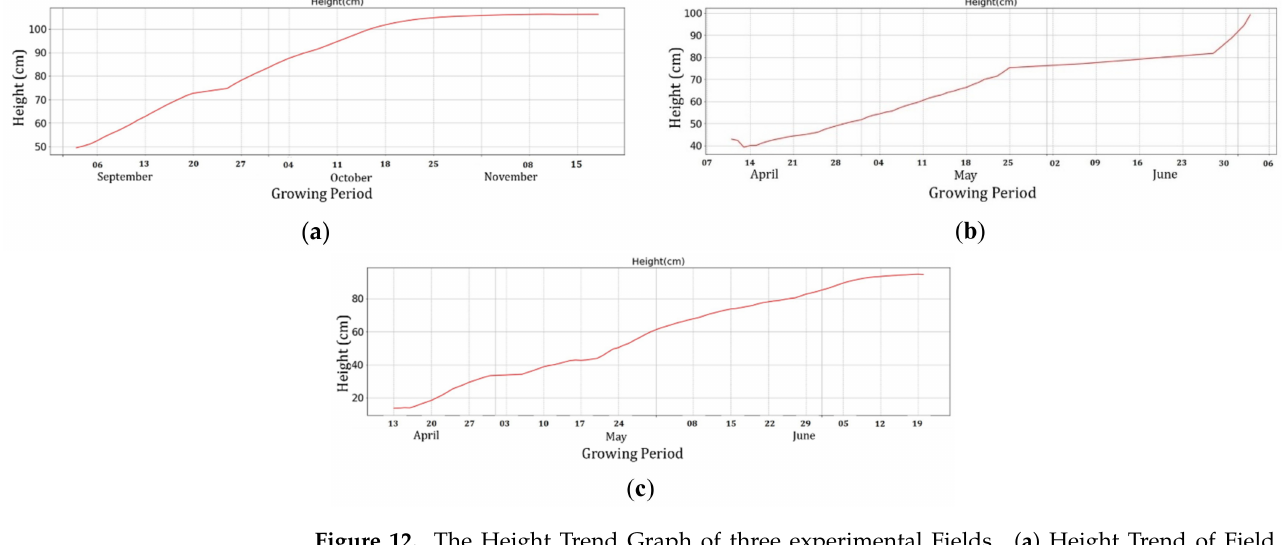
Figure 12. The Height Trend Graph of three experimental Fields. ( a ) Height Trend of Field 1. ( b ) Height Trend of Field 2. ( c ) Height Trend of Field 3.